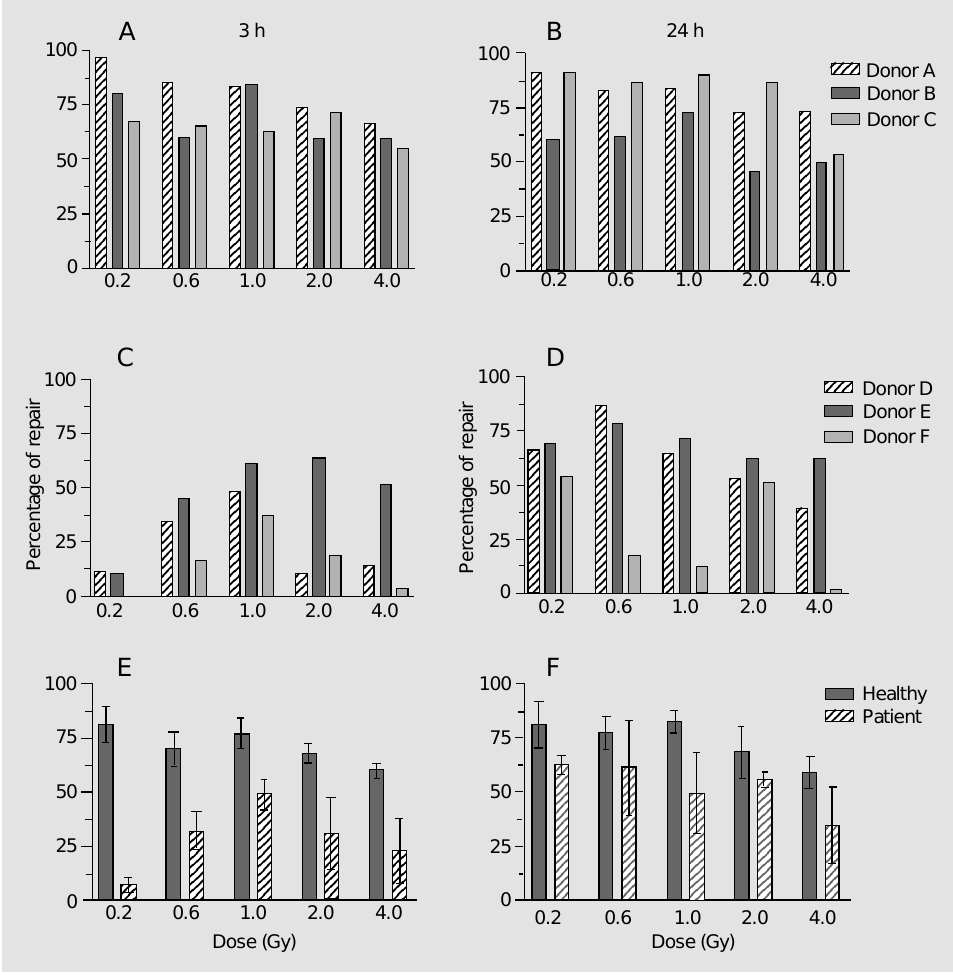
Figure 2 - Repair capacity ob- served in blood samples from 3 healthy donors (A, B), 3 breast cancer patients (C, D) and group means (E, F), 3 and 24 h after in vitro exposure to 60